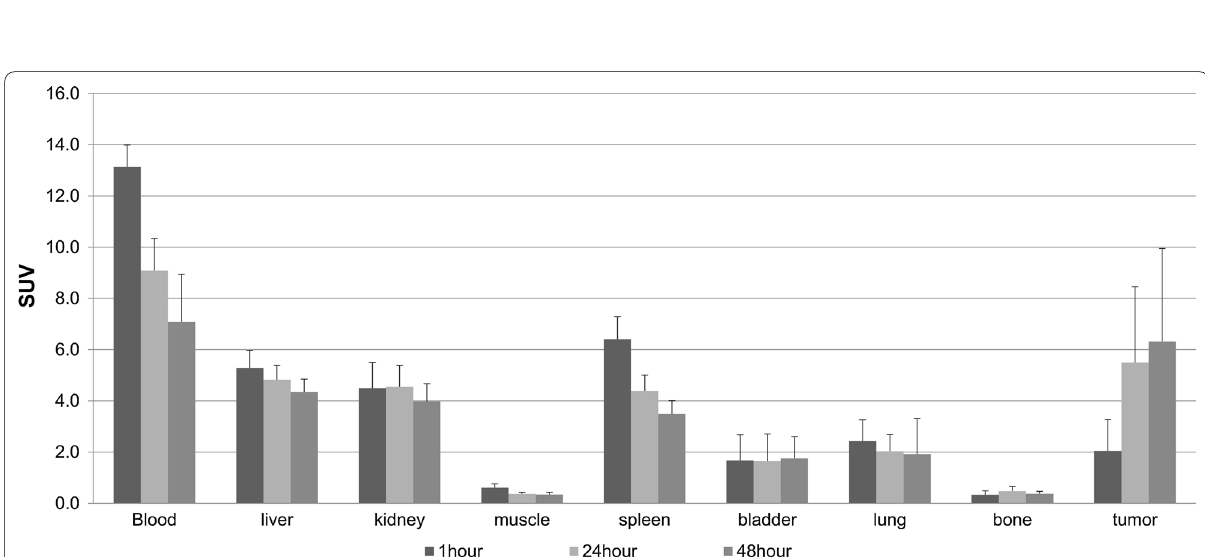
Fig. 1 Residence time derived from serial positron emission tomography images (PET). Mean organ residence times ( 64 Cu‑NOTA‑Trastuzumab